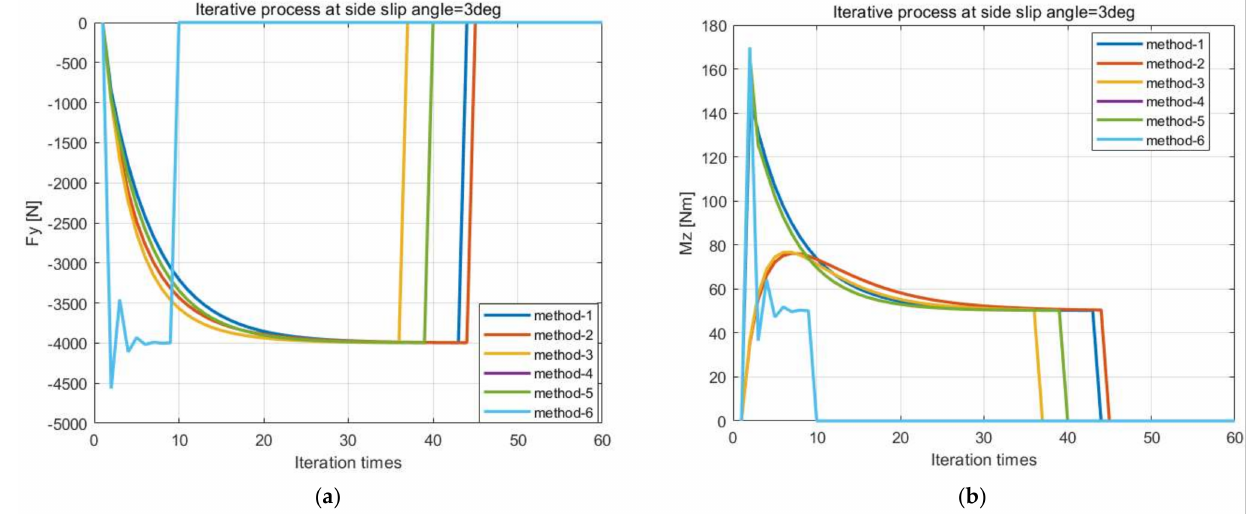
Figure 6. Curves of lateral force and aligning moment with iteration times ( a ) Fy responses with iteration times; ( b ) Mz responses with iteration times.